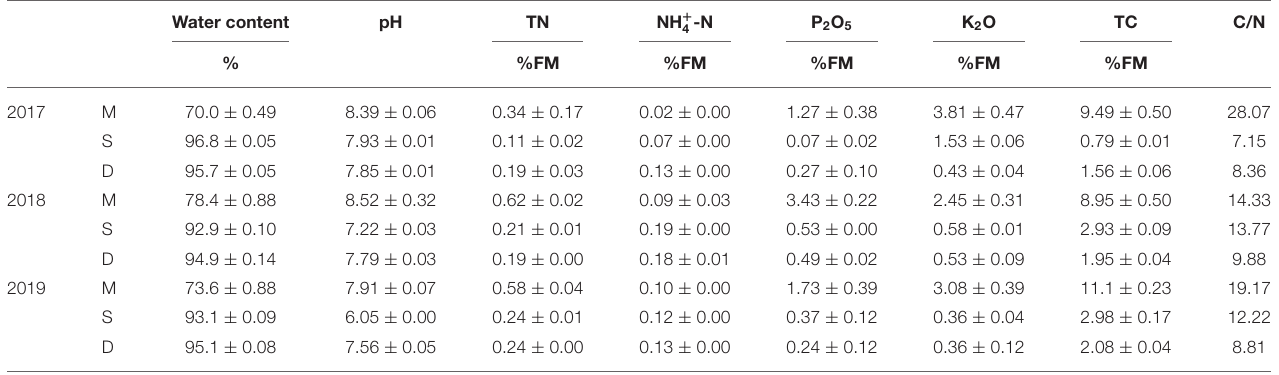
TABLE 1 | Chemical components of organic fertilizer used.